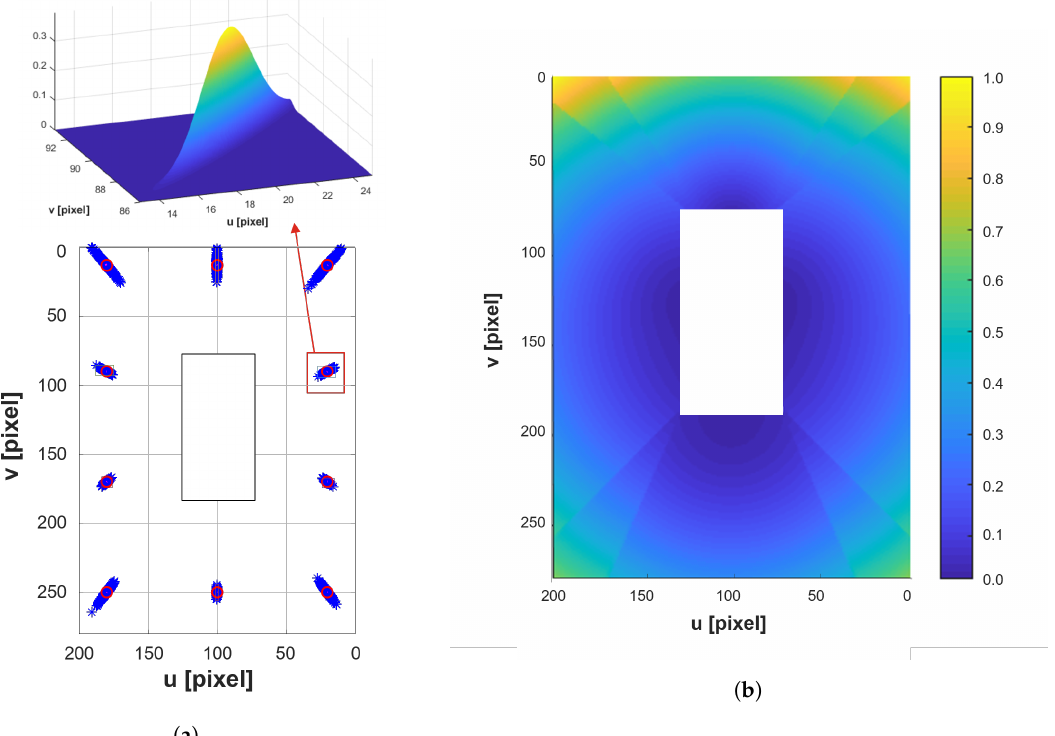
Figure 3. Variance of the Gaussian noise distribution for the AVM system ( b ) due to the vehicle motion caused by roll and pitch ( a